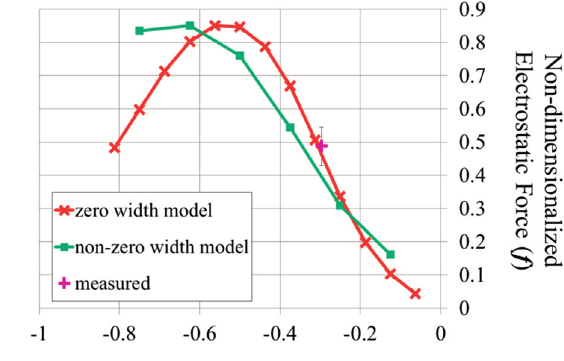
Figure 7. A comparison of two different predictions of the electrostatic force to that measured in the vertical comb drive shown in Figures 1 and 6 that has tooth dimensions of w / t T = 0.260, g / t T = 0.276, and t S / t T = 0.384. The electrostatic forces have been non-dimensionalized with respect to Equation